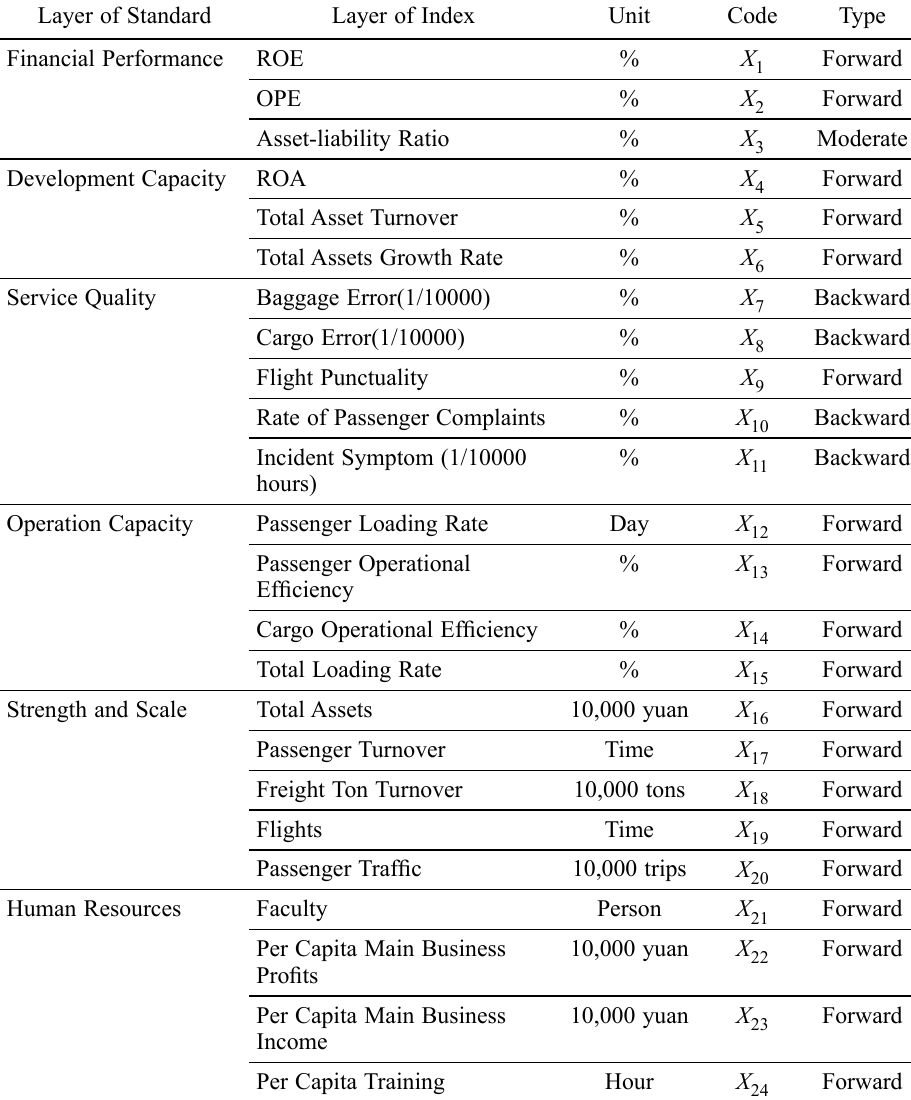
Table 1. Index of airlines’ competitiveness